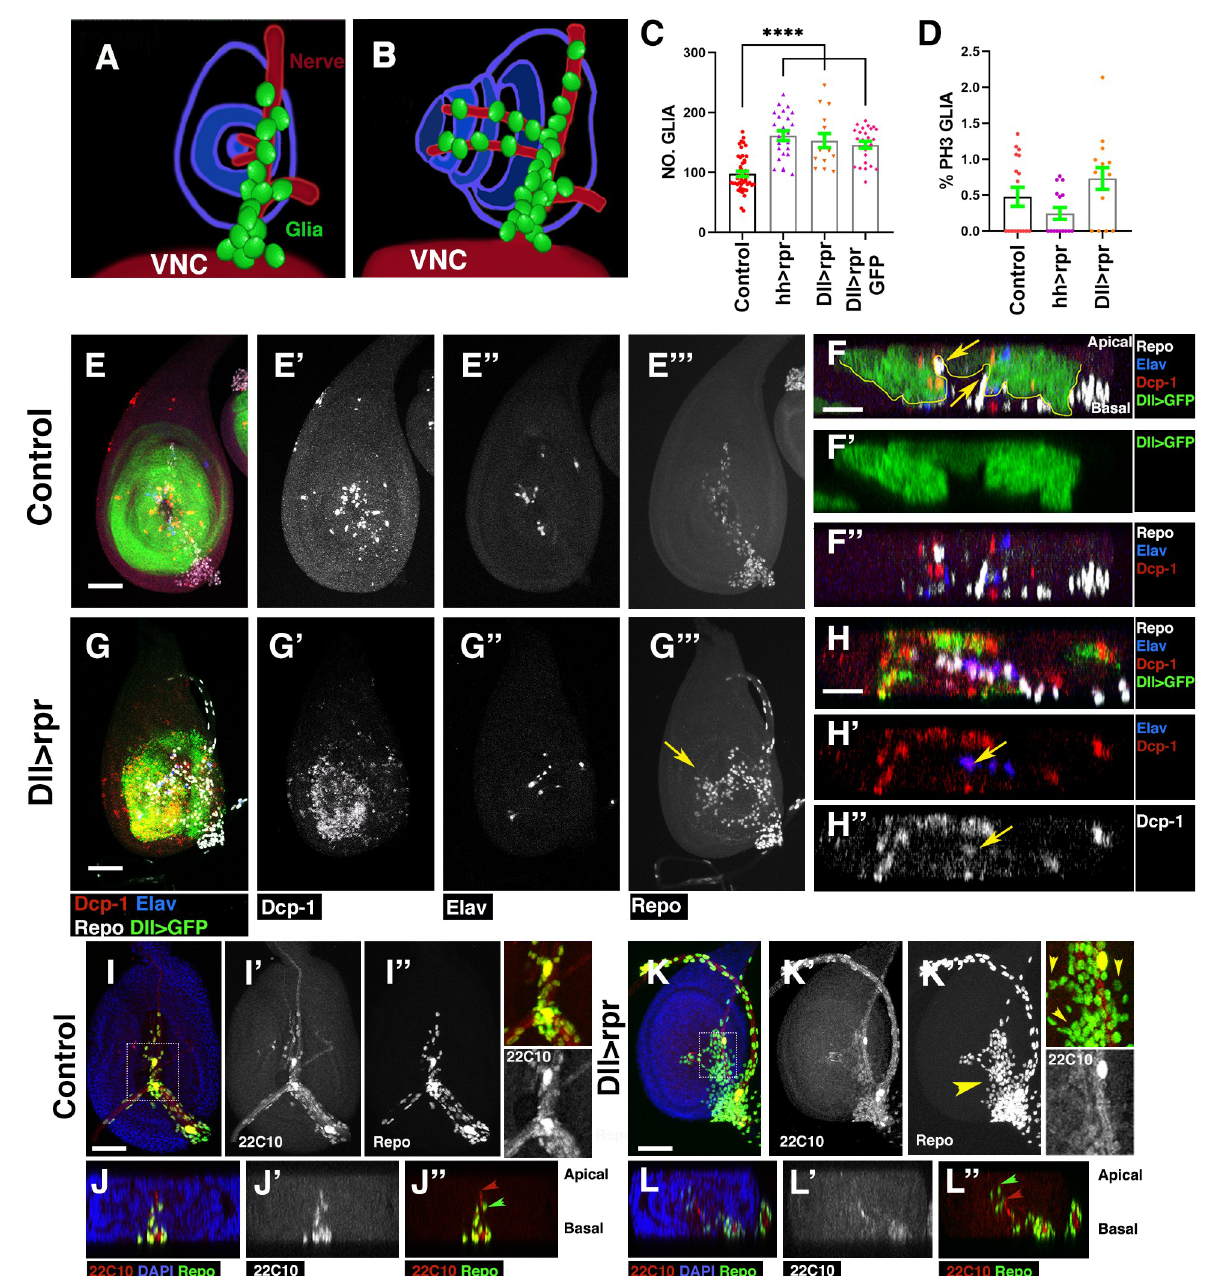
Fig 11. The induction of cell death in the leg disc causes glial cells accumulation in the leg disc epithelium. (A and B) Schematic illustrations of leg discs, frontal view (A) and lateral view (B). Leg discs are concentrically organised, and they are connected to the VNC through the leg nerve. In third instar larvae, the glial cells in the leg discs (in green) are accumulated along the leg nerve (in red) and along 2 nerves into the telescoping leg. (C) The graph indicates the total number of glial cells in control and leg discs after cell death induction using Dll-Gal4 and hh-Gal4 lines. (H) Histogram showing the percentage of glial cells in mitosis (PH3 positive) in leg discs analysed in C. (E–E”” and G–G””) Projections of confocal image stacks of control Dll-Gal4 tub-Gal80 ts /UAS-mCD8-GFP (E–E”’), and UAS-rpr ; Dll-Gal4 tub-Gal80 ts / UAS-mCD8-GFP (G–G””) leg discs after inducing cell death. (F–F” and H–H”) X–Z projections show a cross section of the leg discs epithelium shown in E (F–F”) and G (H–H”). The discs were stained for anti-Repo (white in E, E”’, F, F”, G, G”’, and H) anti-Dcp1 (red in E, F, F”, G, H, and H’ and grey in E’, G’, and H”), anti-Elav (blue in E, F, F”, G, H, and H’ and grey in E” and G”), and Dll > CD8GFP (green in E, F, F’, G, and H). Dll-Gal4 is not expressed in glial cells, since these cells do not express GFP under the control Dll-Gal4 (yellow arrows in F). The overexpression of UAS-rpr under the control of Dll-Gal4 tub- Gal80 ts induces cell death throughout the leg discs epithelium, including some of the neurons forming part of the sense organs contained in this structure (yellow arrows in H’ and H”). (I–I” and K–K”) Projections of confocal image stacks of control Dll-Gal4 tub-Gal80 ts (I–I”) and UAS-rpr ; Dll-Gal4 tub-Gal80 ts (K–K”) leg discs after inducing cell death. (J–J” and L–L”) Cross section of the leg discs shown in I (J–J”) and K (L–L”). The leg